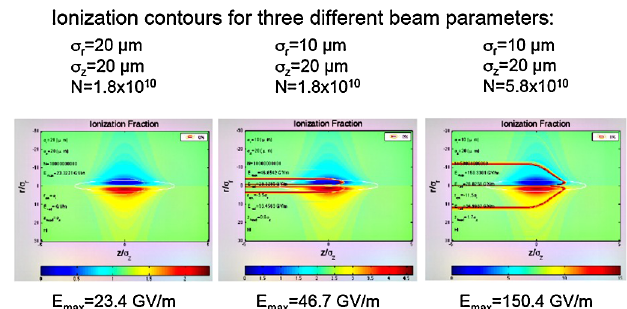
FIG. 2. Simulation of hydrogen ionization by positron beam. In the left figure, the field is lower than threshold and there is no ionization. In the middle figure, the field is slightly larger than threshold causing a streak of ionization. In the right figure, the field is much larger than threshold with a large amount of ionization, but the position density is unrealistically